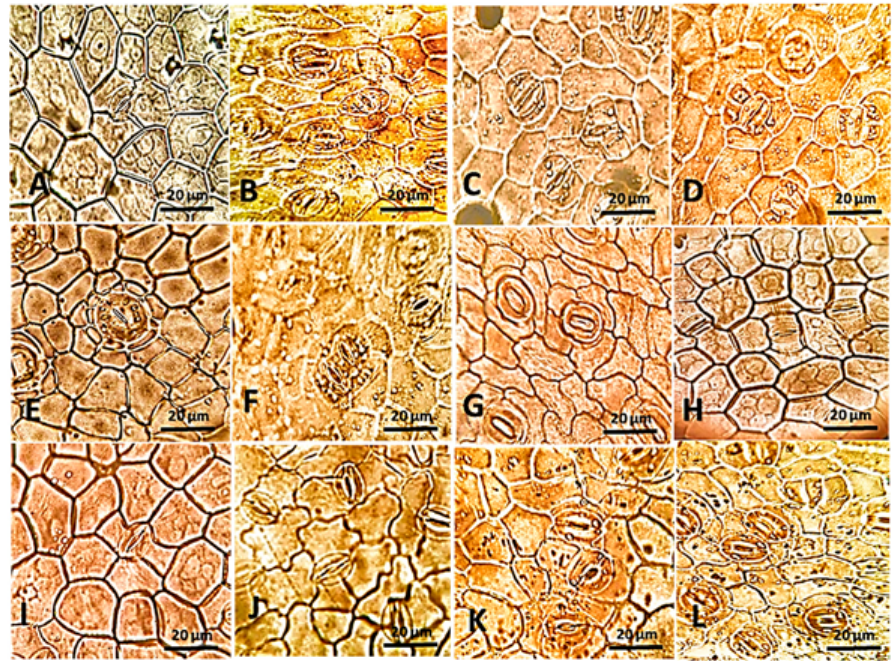
Figure 2. The epidermal surface showing di ff erent types and shapes of stomata in the studied Apocynaceous leaves examined by a light microscope at 140 × . ( A ): A. obesum, ( B ): T. neriifolia , ( C ): C. procera , ( D ): D. boliviensis, ( E ): A. oblongifolia, ( F ): C. carandas, ( G ): A. obesum, ( H ): D. boliviensis , ( I ): C. procera. ( J ): T. neriifolia, ( K ): D. boliviensis , and ( L ): A.